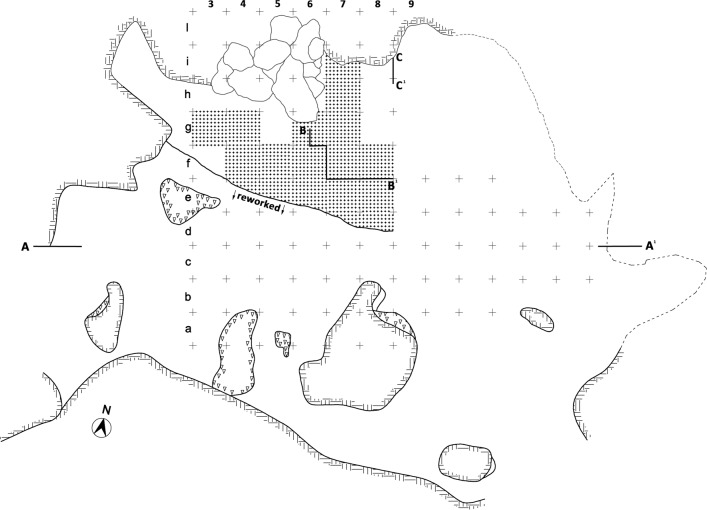
La Fabbrica.Plan of the excavated squares with Mousterian materials in situ (dotted pattern) studied in this paper. The Mousterian layer 1 (1a -1c) rests on the bedrock. Sections A-A1, B-B1 and C-C1 are illustrated in Fig 5.